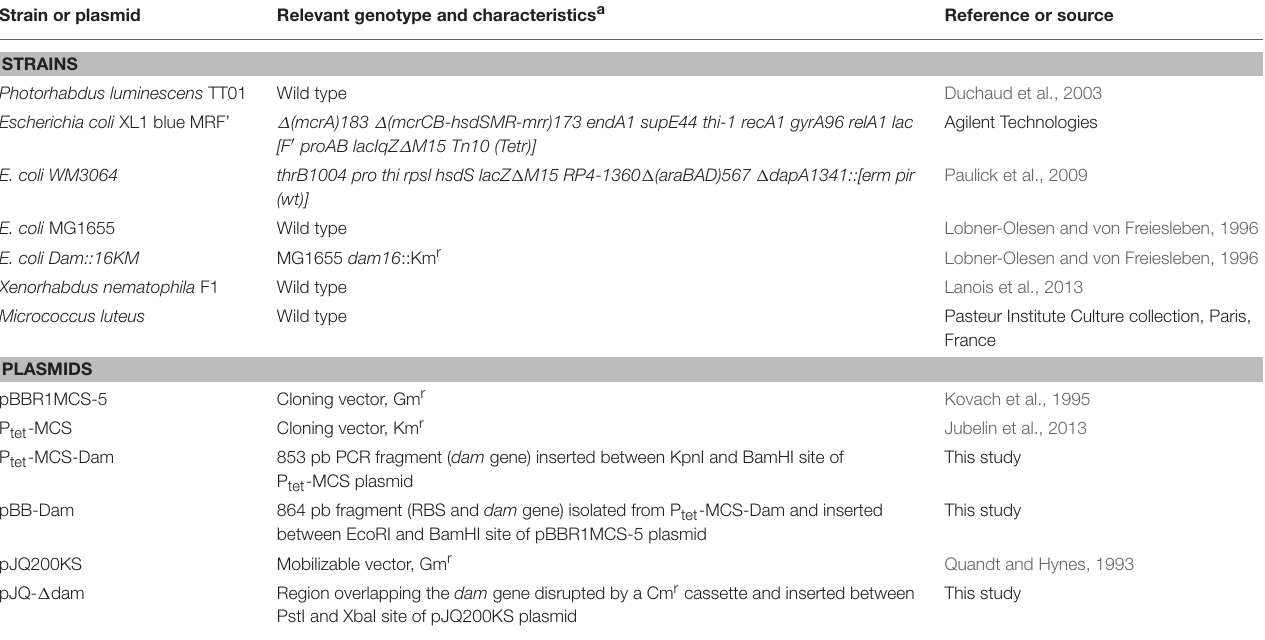
TABLE 1 | Strains and plasmids used in this work. Strain or